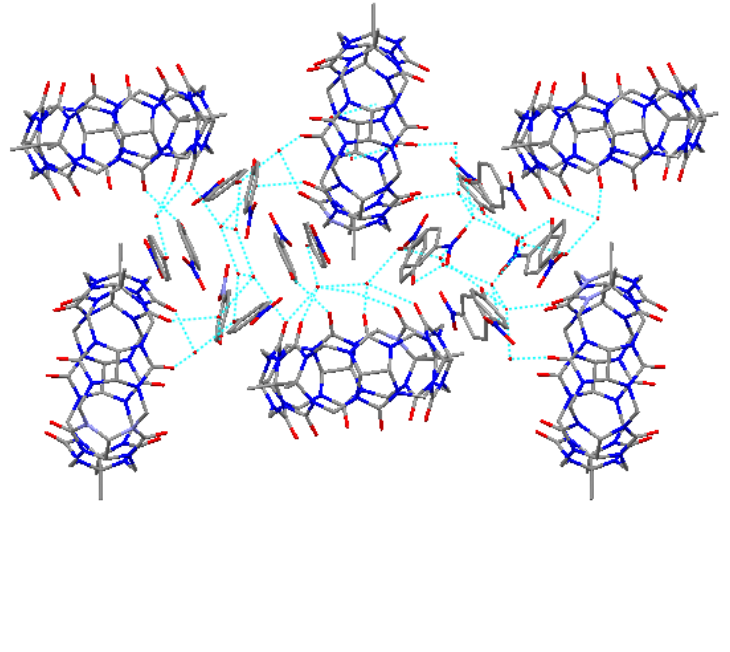
Figure 6 . The assembly based on TMeQ[6] and 4-nitrophenol in the compound 1